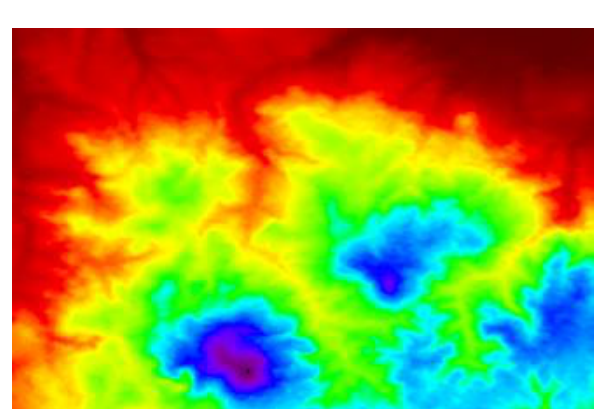
Figure 6: The global ASTER DEM over the test site.